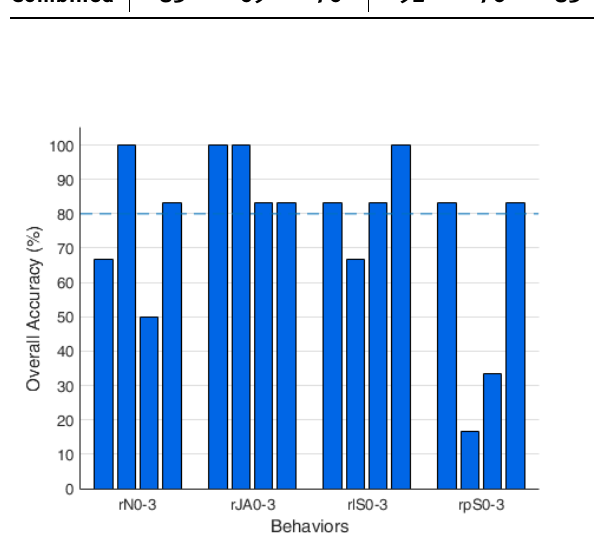
Figure 6: Average accuracies for each robot behavior across the two studies. 11 out of 16 behaviors have an accuracy above